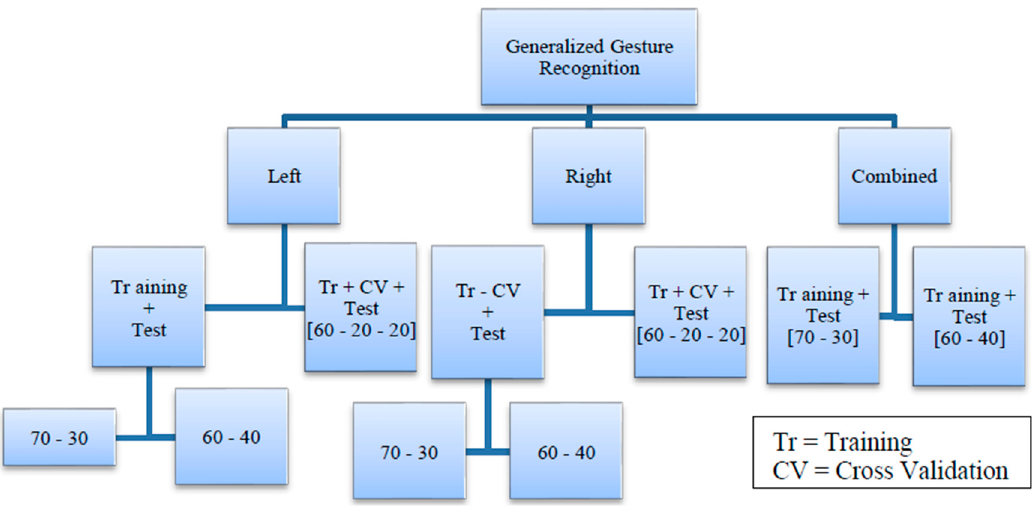
Figure 8. Dataset splits for Generalized Gesture Recognition.